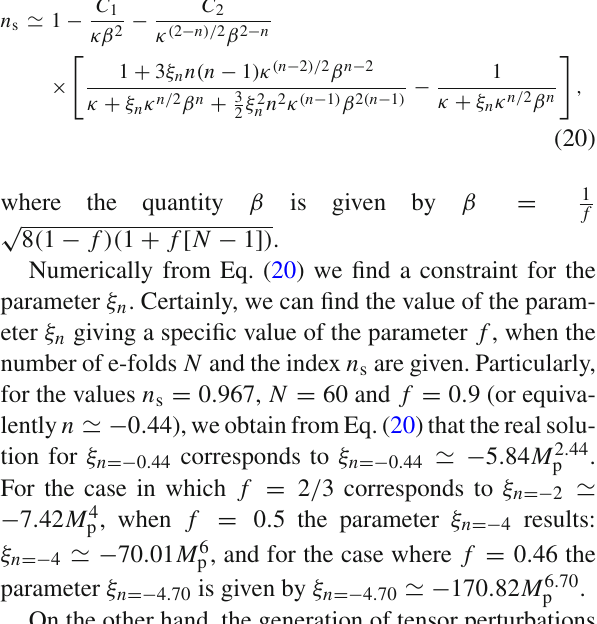
Fig. 1 The tensor-to-scalar ratio r versus the spectral index n s . Here, fromPlanckdata,twodimensionalmarginalizedconstraintsontheratio r and n s (at1 σ confidencelevel,i.e.,68%andat2 σ confidencelevel,i.e., 95%). In this plot, the dotted, solid, and dashed lines correspond to the values of f = 0 . 46 together with the value ξ n =− 4 . 7 = − 170 , 82 M 6 . 7 p , ( f = 0 . 5 ,ξ n =− 4 = − 70 . 01 M 6 p and ( f = 2 / 3 ,ξ n =− 2 = − 7 . 42 M 4 p ), respectively. Here, we have used the value M p = 1 (cid:9) )( 2 − (cid:7) + δ ( 1 + δ T T 1 ν ≡ γ + 1 / 4 , γ = T T T